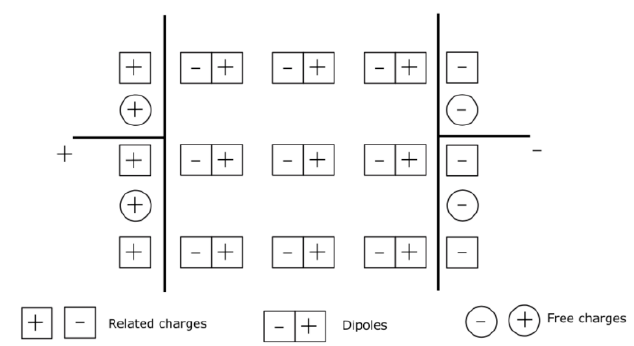
Figure 7. Illustration of polarization in a dielectric material.